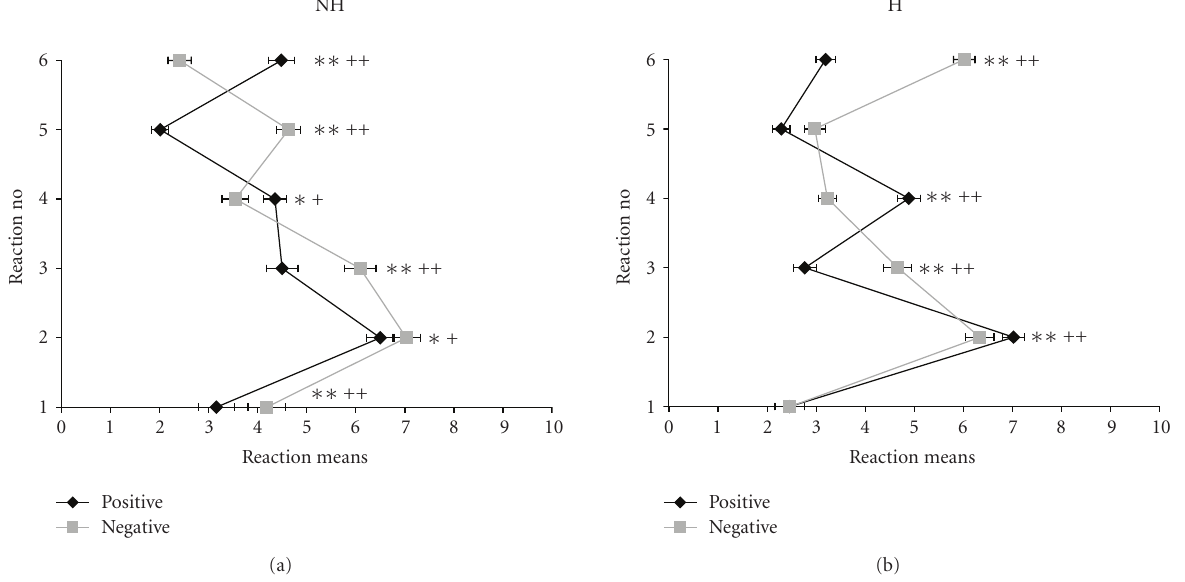
Figure 1: mean reactions + SEM to withdrawal of positive reinforcers (pos) and encounter with negative reinforcers (neg) in nonhuman (NH, (a)) and human (H, (b)) conditions of frustration (1–6 see responses to QDF scales in Section 2.1., 1 + 5 = depressive, 3 + 6 = aggressive, and 2 + 4 = indi ff erent responses; ∗ P < . 05; ∗∗ P < . 01 before Bonferroni adjustment; + P < . 05; ++ P < . 01 after Bonferroni adjustment of significance level).